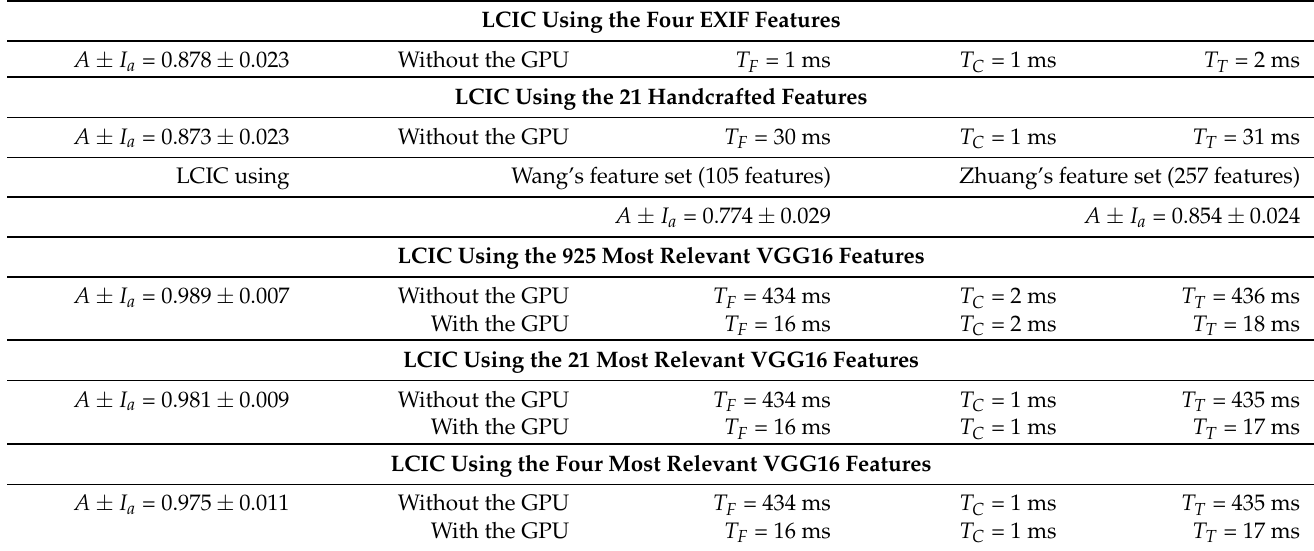
Table 3. LCICs using EXIF features, handcrafted features and learned features. LCIC Using the Four EXIF